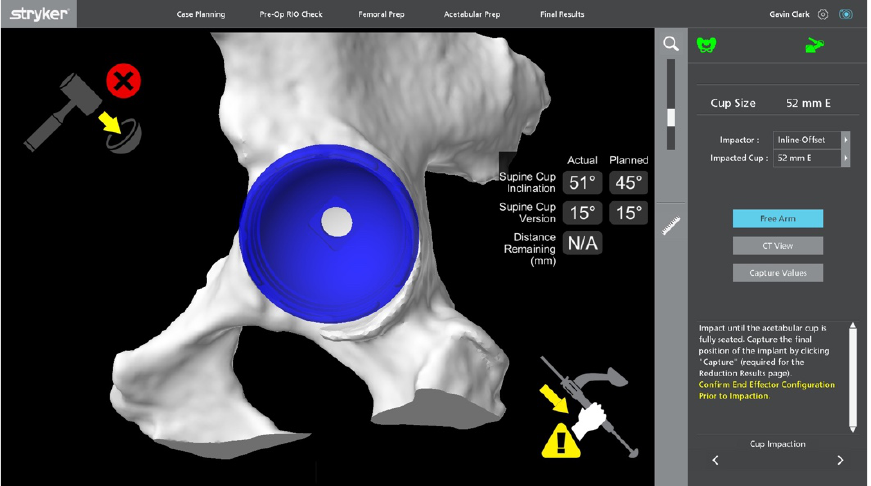
Figure 11. Feedback of depth of cup impaction. The red cross in the top right indicates the system is not “locked in”, and as indicated by “distance remaining”, the cup is placed in accordance with the plan.